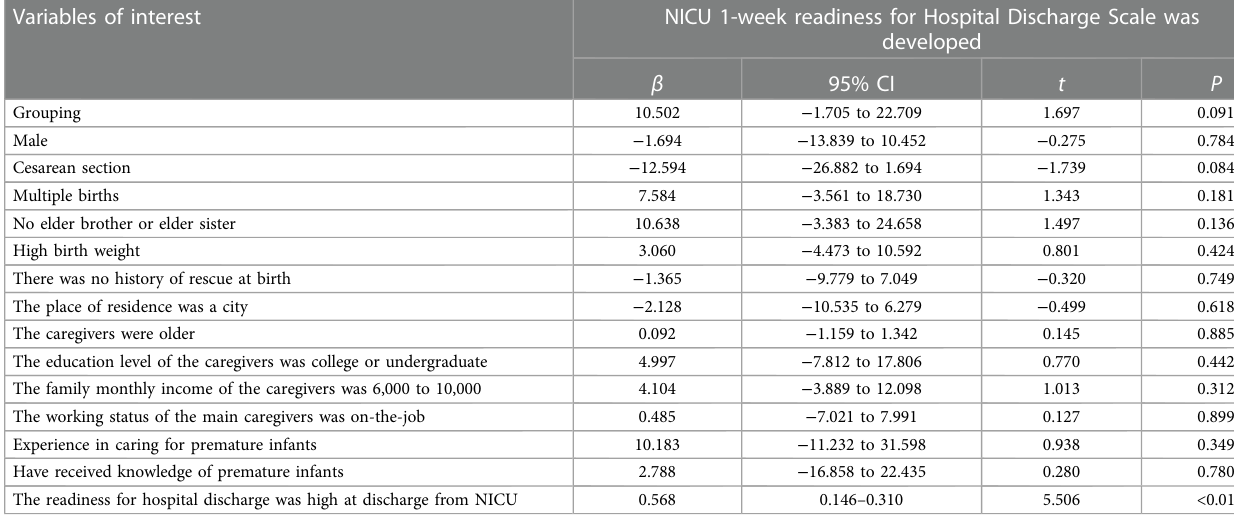
TABLE 7 Linear regression analysis of discharge readiness of primary caregivers of preterm infants at 1 week after NICU. Variables of